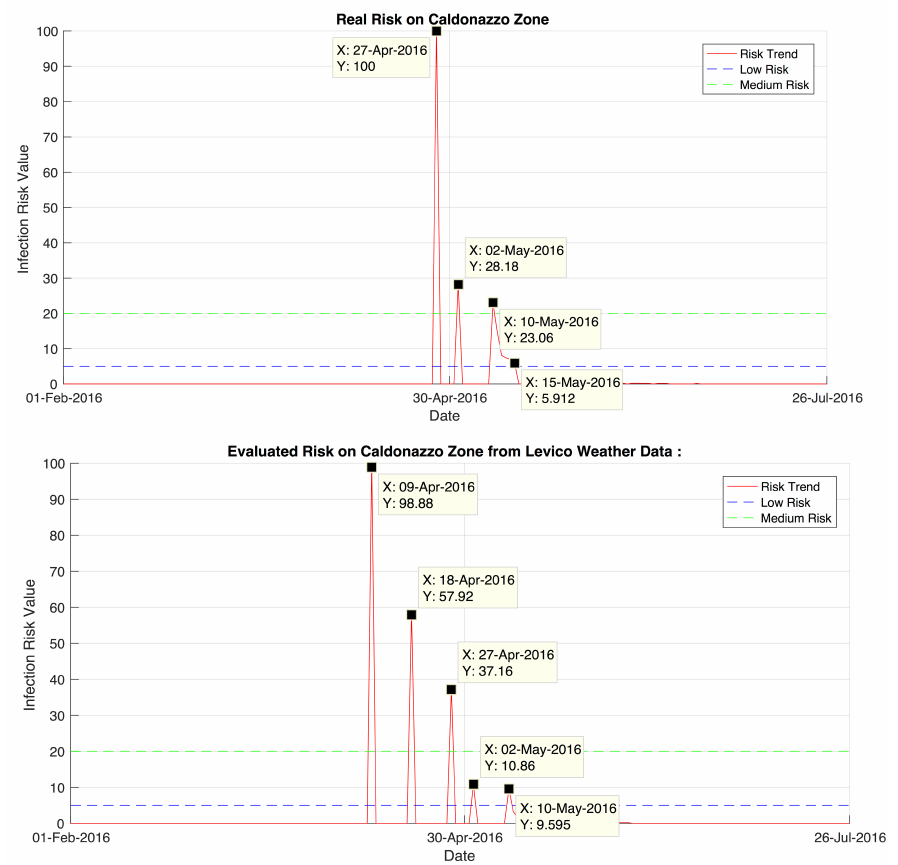
Figure 10. Risk evaluation comparison for Example 1: on the top, risk evaluation for Caldonazzo’s zone using weather data of its own weather station; at the bottom, risk evaluation for Caldonazzo’s zone using weather data of Levico’s weather